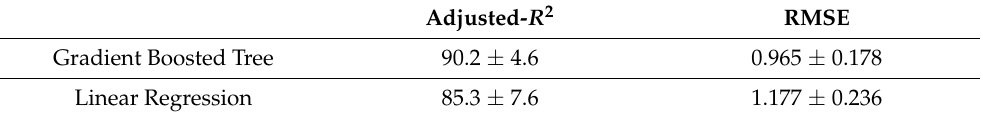
Table 1. Regression Model for Gaze Estimation. Numbers are presented in terms of mean ± std.